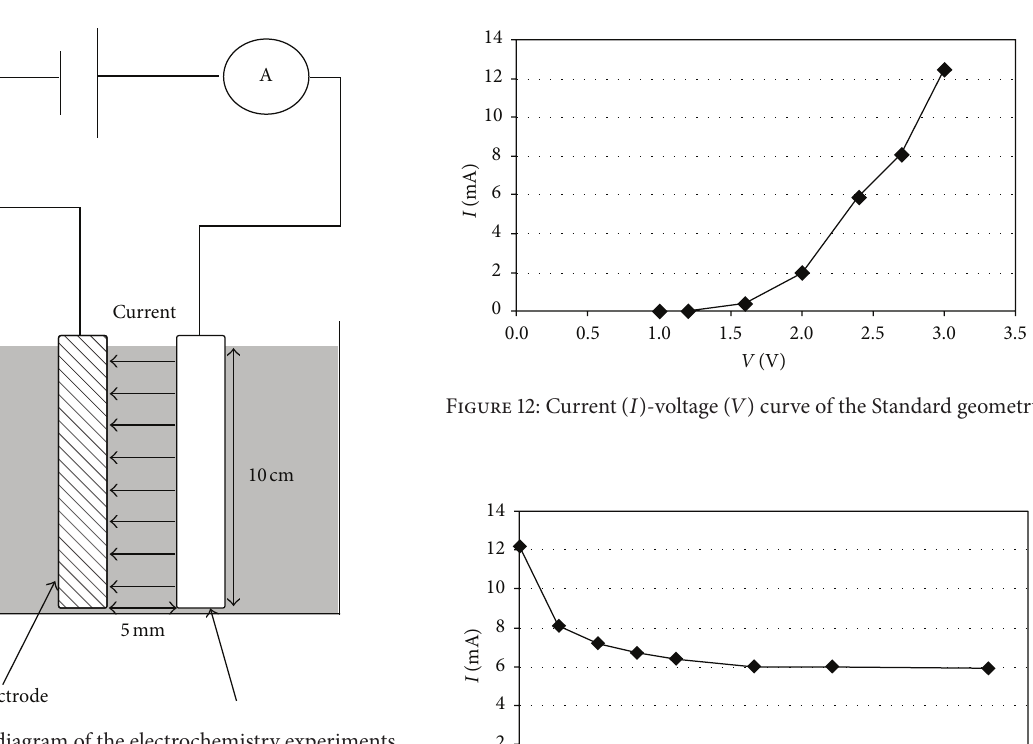
Figure 11: Schematic diagram of the electrochemistry experiments.